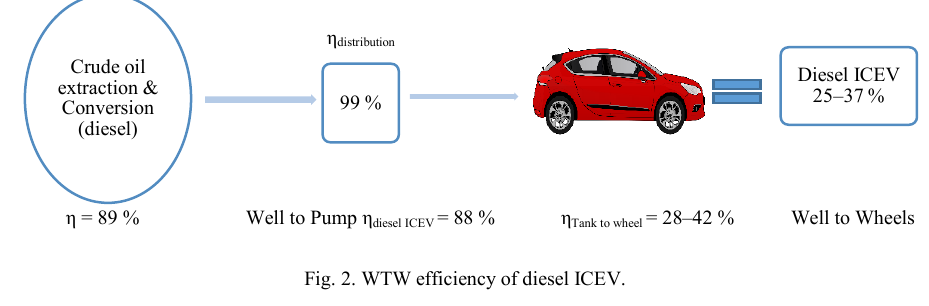
Fig. 2. WTW efficiency of diesel ICEV.